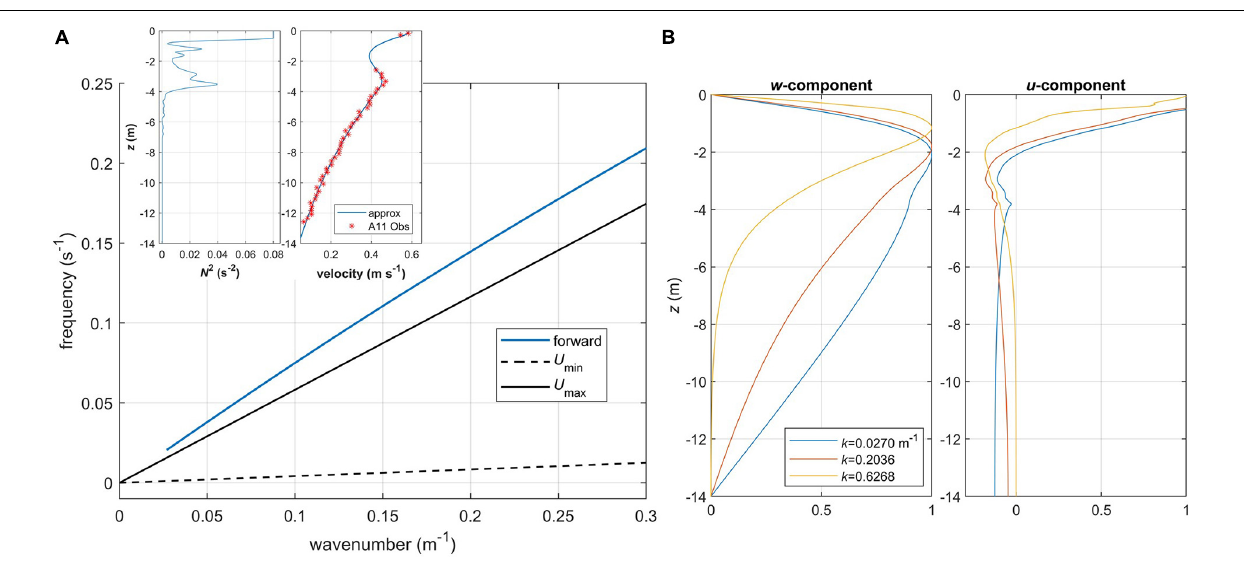
FIGURE 13 | Internal wave properties for realistic conditions from station 11, case 3: (A) dispersion diagram for the first mode. Inset shows specified in Equation A7 profiles of buoyancy frequency squared (left) and mean velocity (right), where asterisks/line show the observed/approximated values, respectively; (B) vertical profiles of vertical and horizontal velocity components normalized by their maximum values for various wavenumbers k , forward propagating